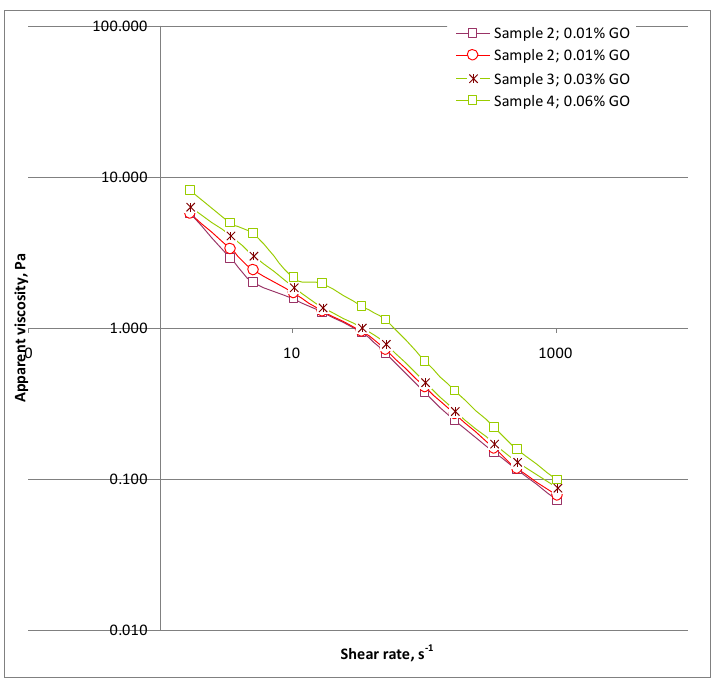
Figure 2. Graph of apparent viscosity change versus shear rate for slurries containing graphene oxide without a latex admixture.